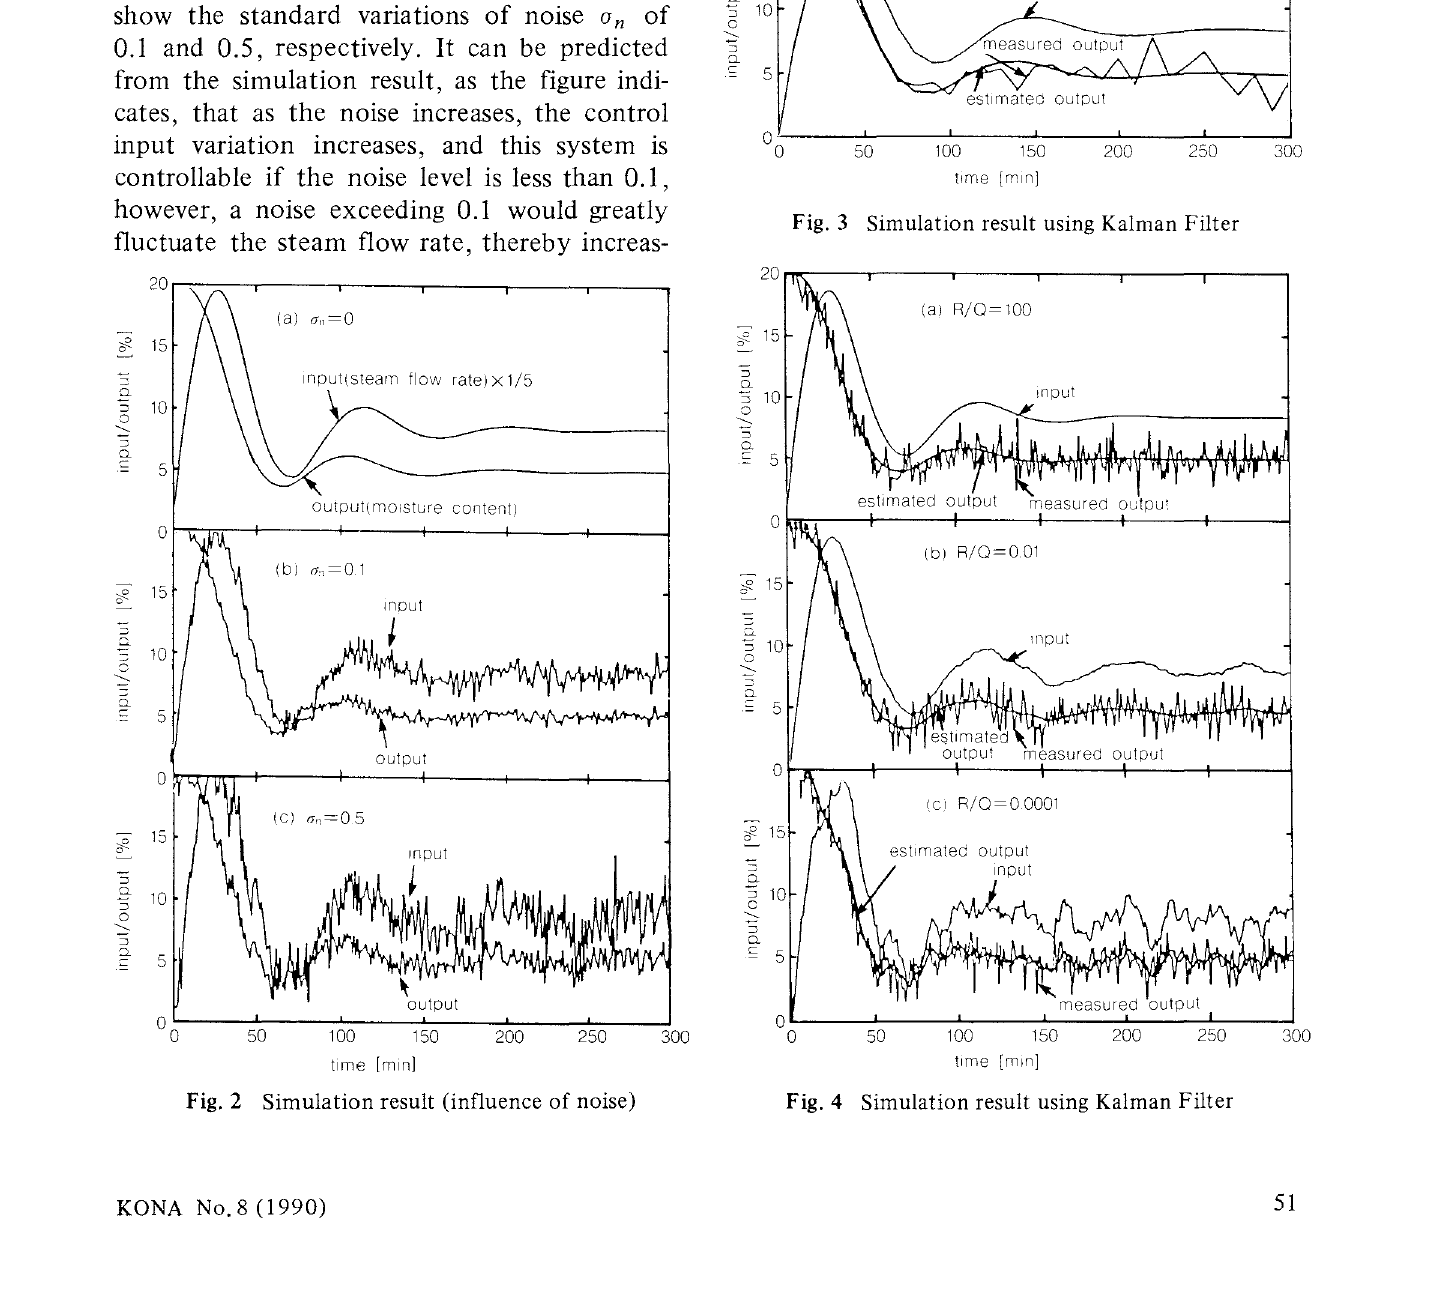
Fig. 2 Simulation result (influence of noise)